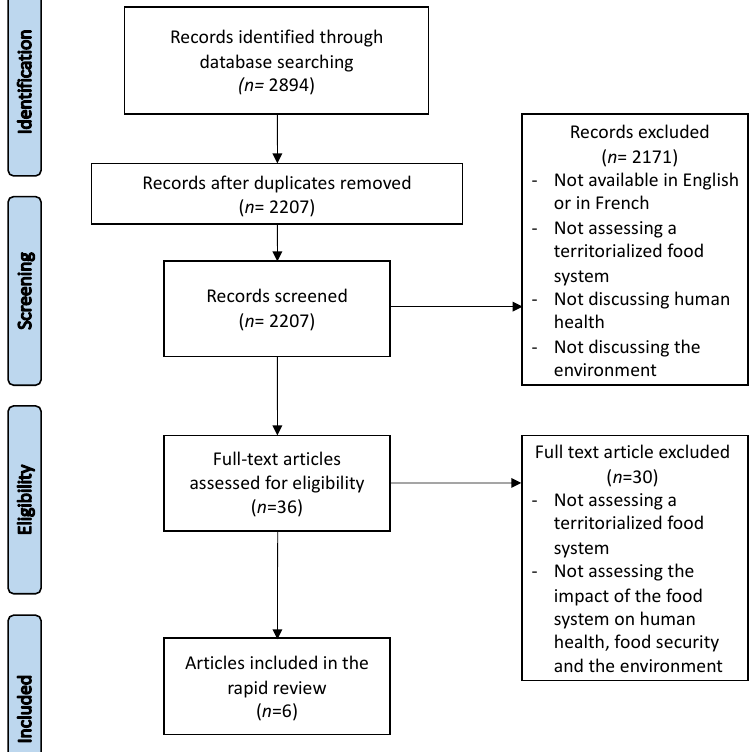
Figure 1. Flow diagram of the article selection process.